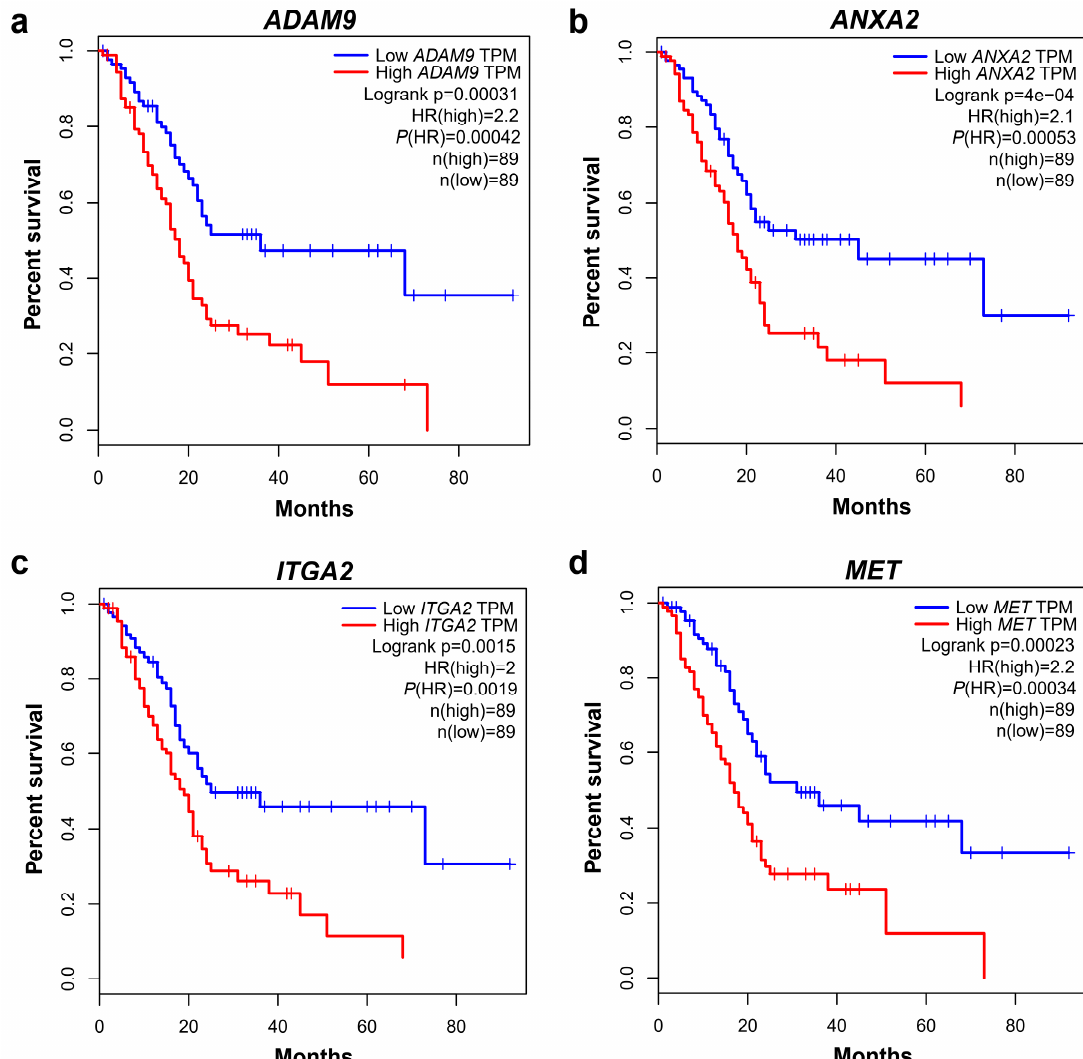
Figure 2. Kaplan–Meier (KM) plots of the overall survival of four promising prognostic candidates. ( a ) KM plot of ADAM9 . ( b ) KM plot of ANXA2 . ( c ) KM plot of ITGA2 . ( d ) KM plot of MET .